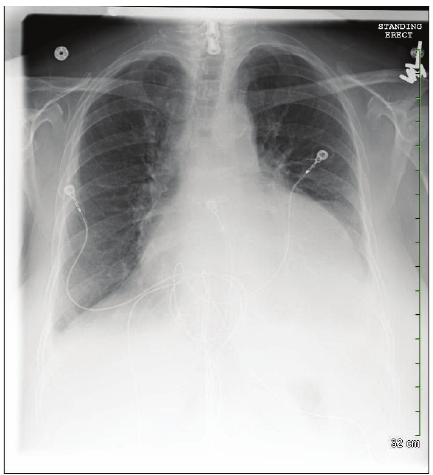
Figure 1: PA CXR showing cardiomegaly, interstitial edema, and small bilateral effusions.